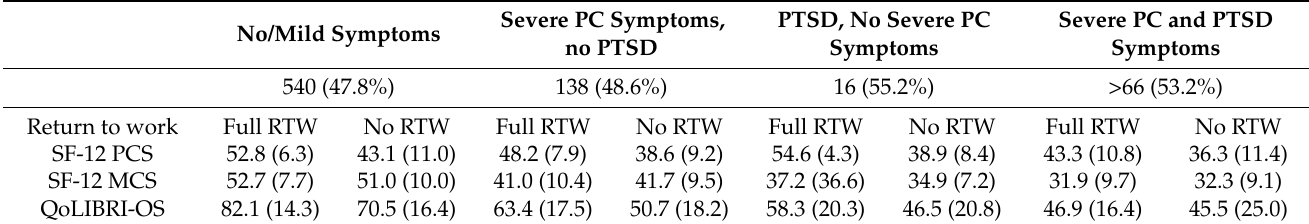
Table A6. HRQoL for patients who returned to work at full level or did not at 6 months.